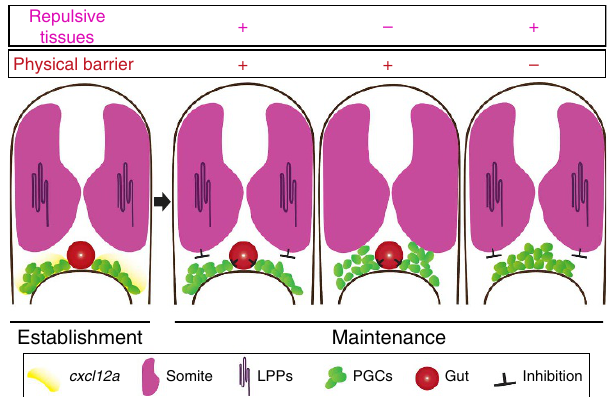
Figure 8 | Progenitor cell positioning at target site. An illustration demonstrating the interplay of repulsive cues and physical barriers within the embryo that govern the positioning of PGCs at the site of the developing gonad. At the time of PGC clusters initial formation, the guidance cue cxcl12a RNA is expressed at the migration target (yellow). In the following stages the chemokine is not expressed, calling for other mechanisms maintaining the position of the germline progenitors. In wild-type embryos dorsal repulsive tissues (somites expressing LPPs in magenta) inhibit the dorsal migration of PGC clusters, while the developing gut (red) acts as a physical barrier separating the clusters, thereby contributing to the formation of distinct cell clusters at the site of developing organ. In embryos deficient for the function of LPPs or lacking the physical barrier, the PGCs exhibit abnormal